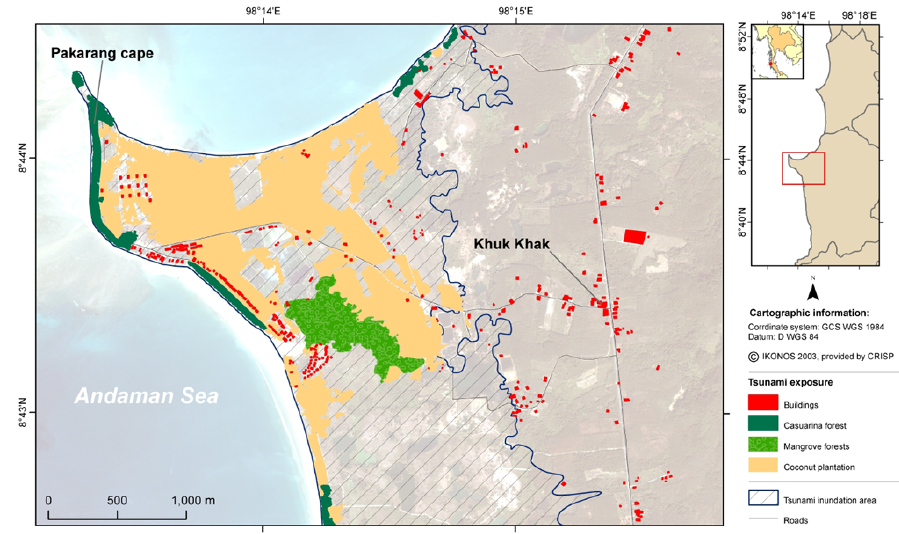
Fig. 11. Exposure map including socio-economic and ecological